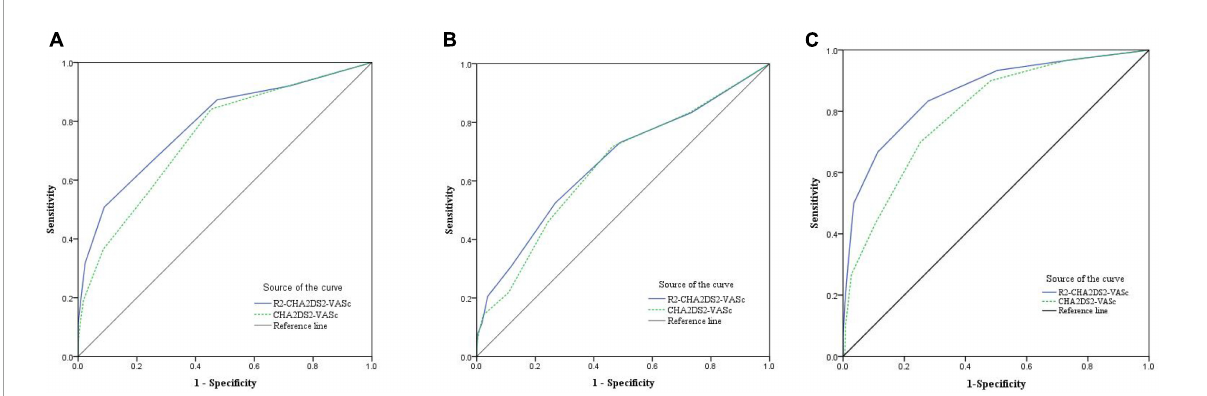
FIGURE1 The ROC curve was used to demonstrate the distinction between the R2-CHA2DS2-VASc score and the CHA2DS2-VASc score and to calculate the cut-off value, sensitivity, and specificity of the R2-CHA2DS2-VASc score in (A) predicting long-term MACE. (B) Predicting no-reflow phenomenon. (C) Predicting worsen heart